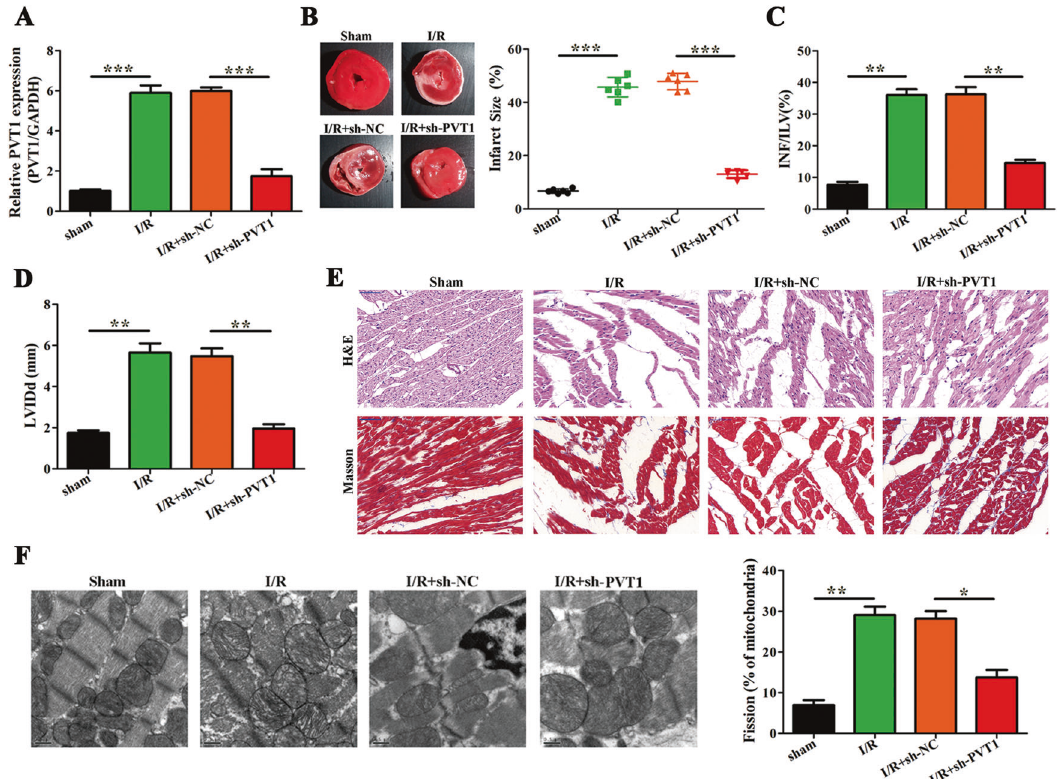
Fig. 4 LncRNA PVT1 promotes myocardial I/R injury and mitochondrial fusion and fi ssion in vivo. A sh-PVT1 or sh-NC was intraperitoneally administered 24 h before myocardial I/R injury ( n = 6 per group). Post I/R injury, RNA was isolated from heart tissues and expression of PVT1 was determined by qRT-PCR. Relative fold change of PVT1 expression with respect to GAPDH is shown ( n = 6). B – D Quanti fi cation of I/R injury. Representative images of heart tissues in the left panel for different groups are shown. Other panels indicate infarct size (%), INF/LV (%), and LVIDd (mm) ( n = 6). E Representative images of H&E and Masson ’ s trichrome staining of left ventricle [43] sections (Scale bar = 50 μ m) ( n = 6). F Representative TEM images of heart tissues are shown in the left panel. Quanti fi cation of fragmented mitochondria is shown in the right panel (Scale bar = 0.5 μ m) ( n = 6). * P < 0.05; ** P < 0.01; *** P <